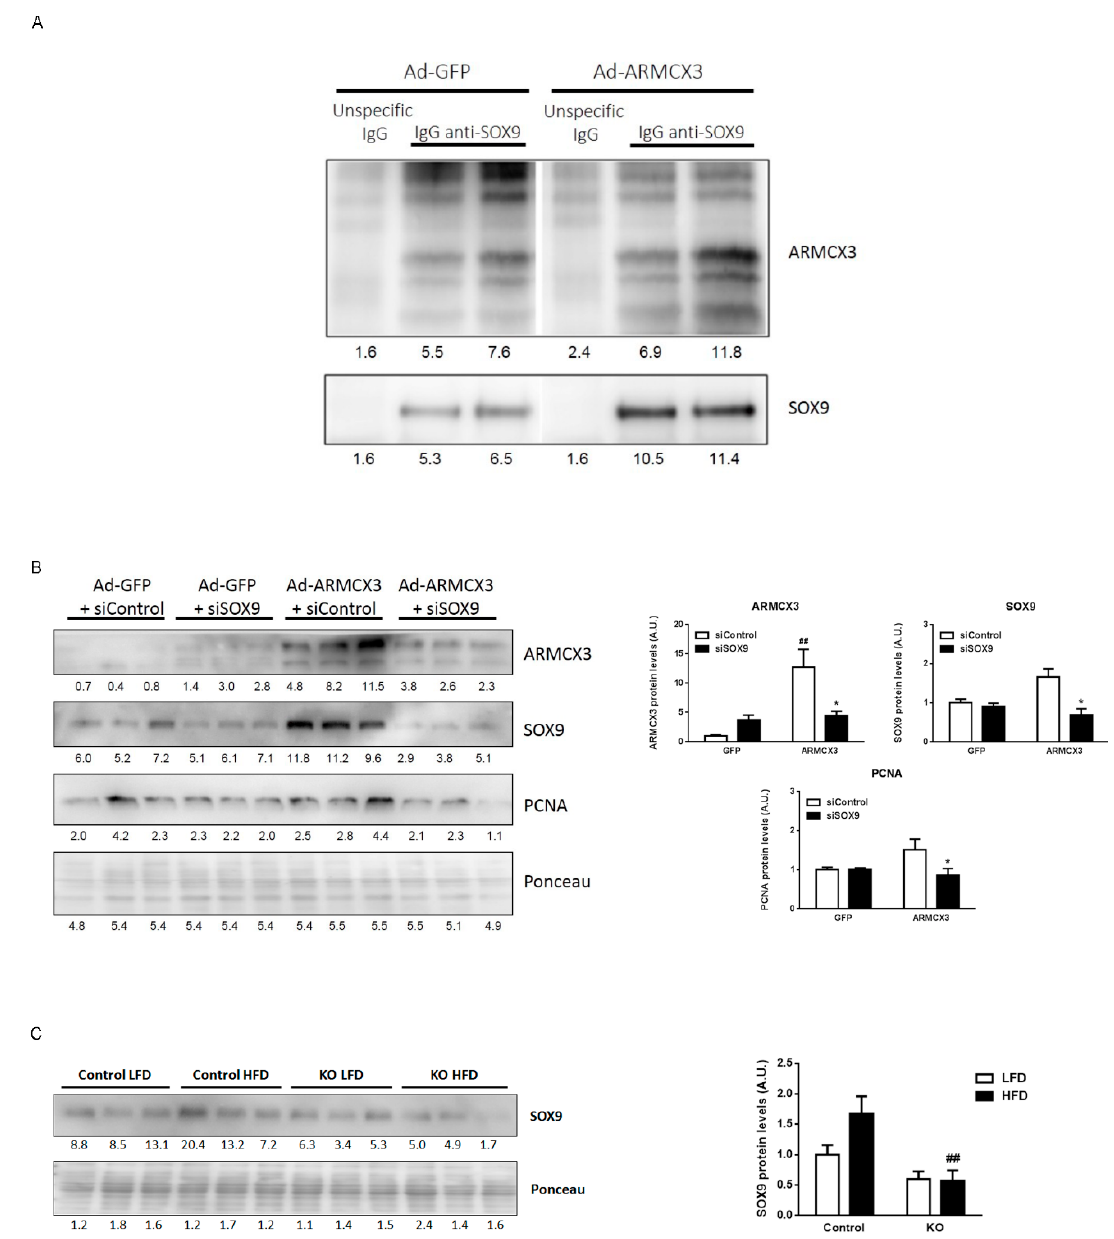
Figure 7. ARMCX3 ‐ induced hepatocyte proliferation involves SOX9. ( A ) Immunodetection of ARMCX3 and SOX9 in SOX9 pull ‐ down samples from HepG2 cells transduced with Ad ‐ GFP or Ad ‐ ARMCX3 at 48 h post ‐ transduction. ( B ) ARMCX3, SOX9 and PCNA levels in HepG2 cells at 48 h after cells were transduced with Ad ‐ GFP or Ad ‐ ARMCX3 and transfected with scrambled siRNA (Control) or SOX9 siRNA. Representative immunoblots (top) and quantification (bottom) are shown. Bars indicate means ± SEM of three independent experiments. Two ‐ Way ANOVA test with Tukey post hoc correction was used. * p ≤ 0.05 for comparisons between siControl and siSOX9, and ## p ≤ 0.01 for comparisons between GFP and ARMCX3. ( C ) SOX9 levels in 7 ‐ month ‐ old fArmcx3/Cre ‐ (Control) or ARMCX3 ‐ KO mice (KO) treated with DEN and maintained on LFD or HFD for 24 weeks. Bars indicate means ± SEM; n = 9–13 mice per group. Two ‐ Way ANOVA test with Tukey post hoc correction was used. ## p ≤ 0.01 for comparisons between genotypes.